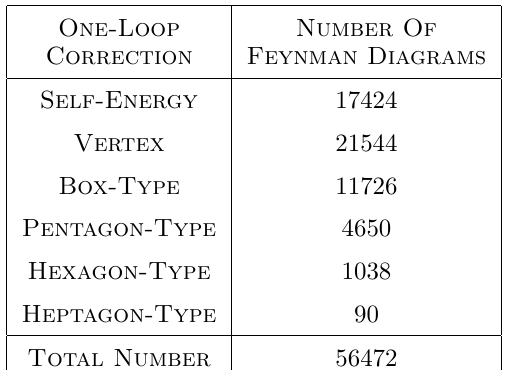
Table 1 . The number of one-loop Feynman diagrams for the dominant gg partonic subprocess at ( (cid:11) 3 (cid:11) 6 ) for the pp e + (cid:23) e (cid:22) (cid:0) (cid:22) (cid:23) (cid:22) b (cid:22) b(cid:23) (cid:28) (cid:22) (cid:23) (cid:28) + X process. The Higgs boson s O ! exchange contributions are not considered and the Cabibbo-Kobayashi-Maskawa mixing matrix is kept